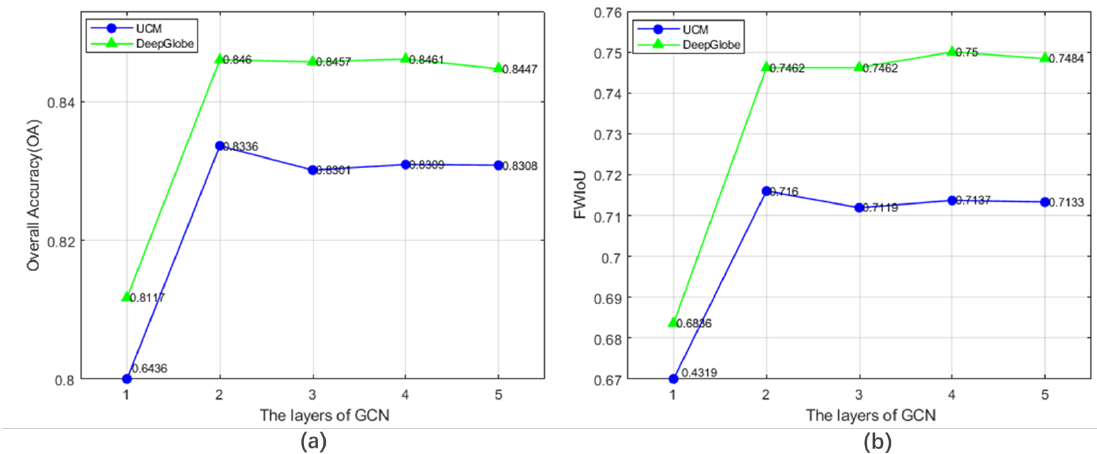
Figure 9. Sensitivity analysis of the number of GCN layers 𝑙 tested on the validation dataset. ( a ) and ( b ) present the change trend of OA and FWIoU with 𝑙 , respectively.